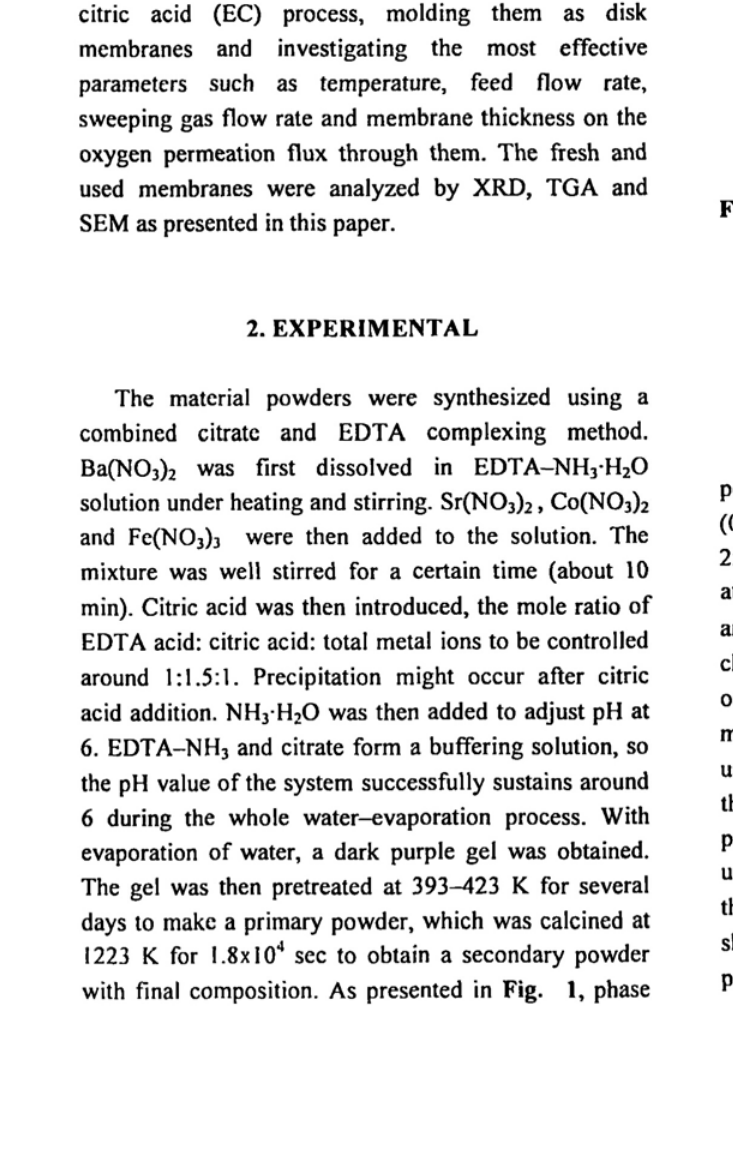
Fig. 1: XRD pattern of the synthesized B oxide powder